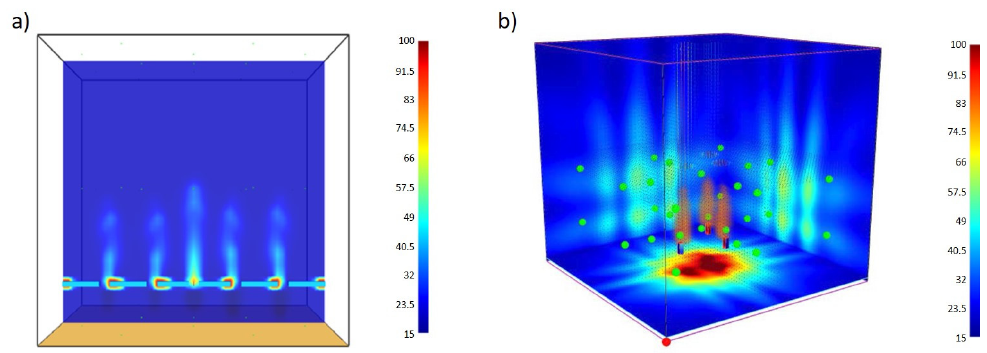
Figure 5. Fire acceleration methods ( a ) hot air injection and ( b ) high temperature points in °C.